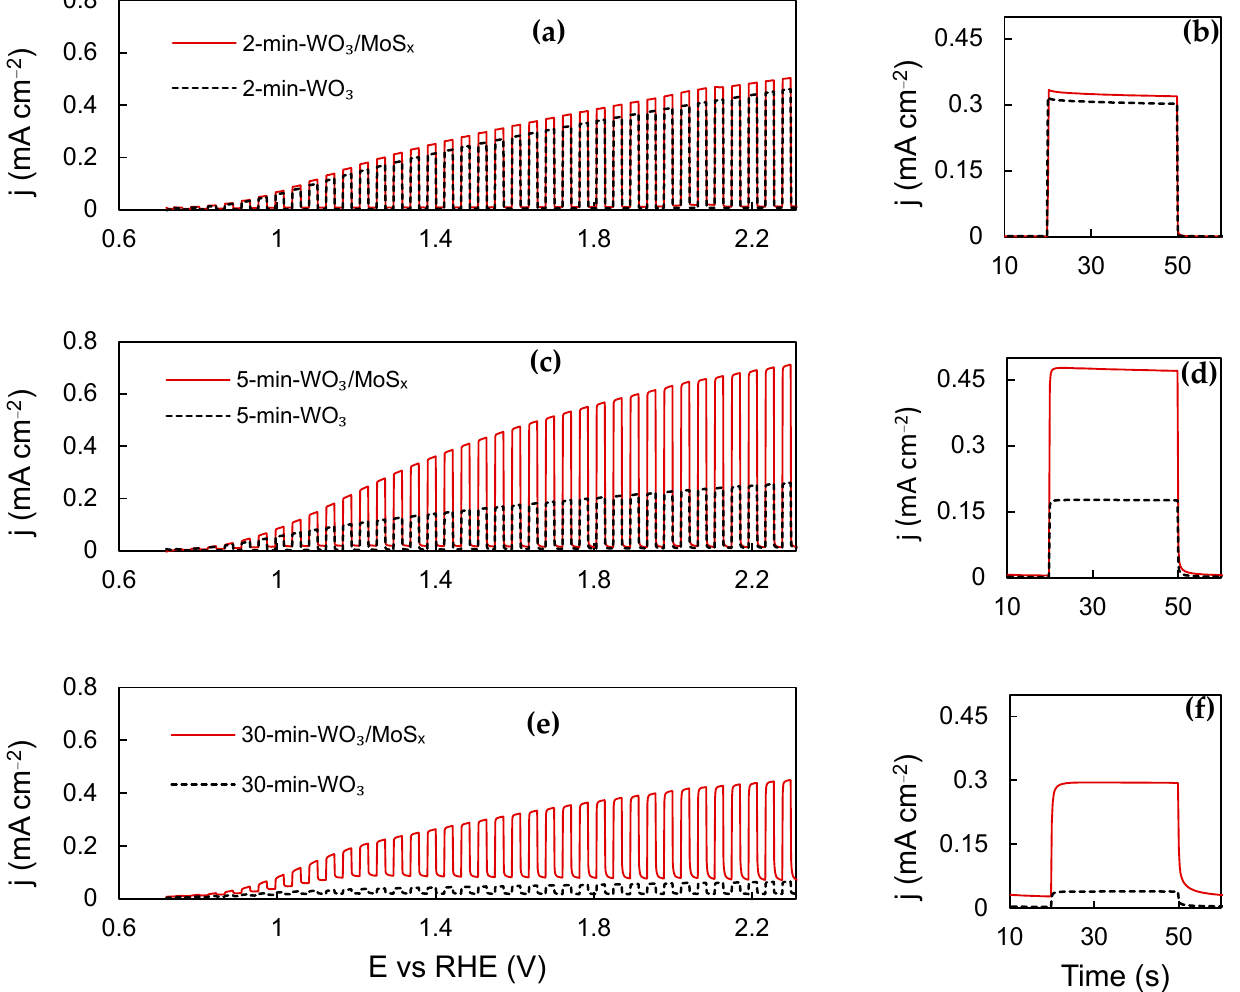
Figure 7. Chopped-UV LSV curves ( a , c , e ) and steady-state photocurrent pulses, measured at 1.53 V ( b , d , f ). See Table 1 for more